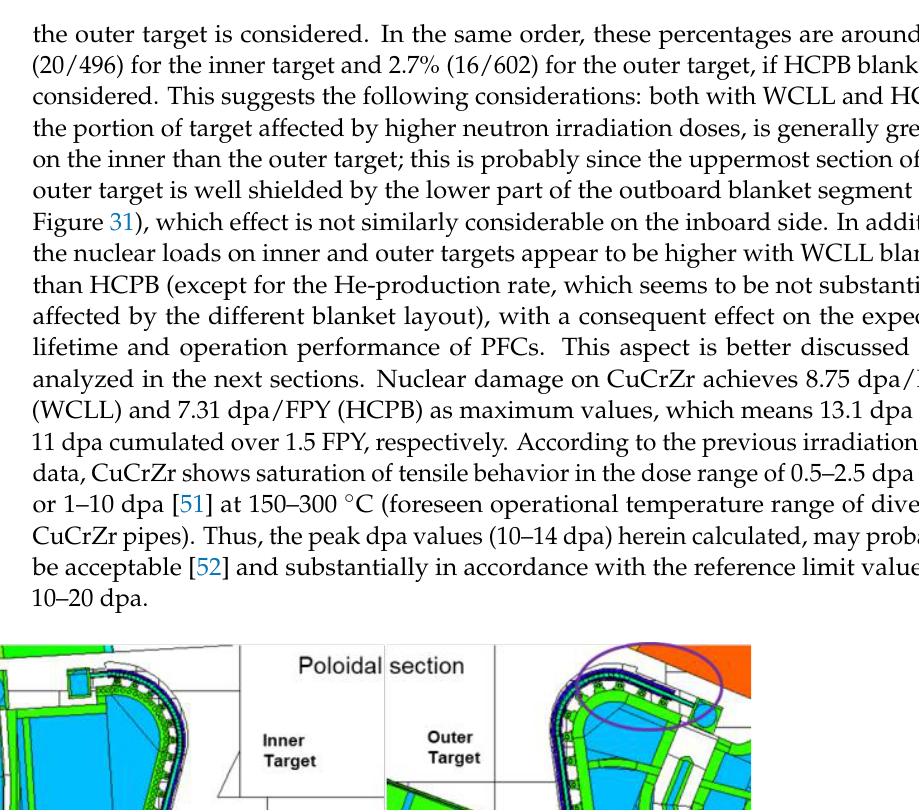
Figure 32. Inner poloidal profiles of the nuclear heating (W/cm 3 ) on W-Monoblocks, comparing the values on the external and the innermost target sides, both for WCLL and HCPB blanket case.